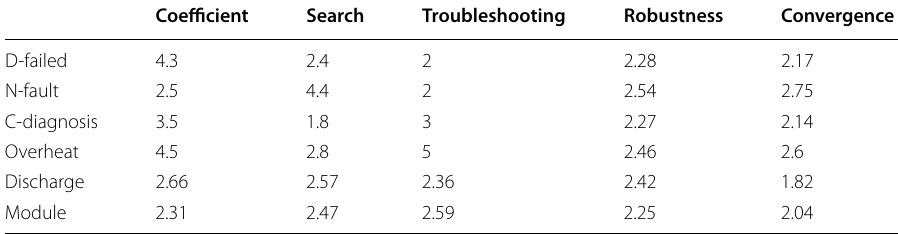
Table 15 False judgment rate of fault